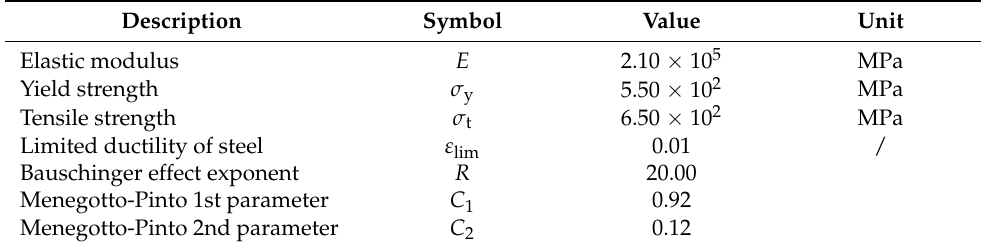
Table 4. Bilinear steel material